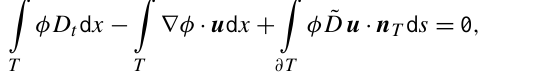
Fig. 10. Linear shallow water equations: kinetic E k , potential E p , and total energy E T versus time t for an implicit midpoint in time and RT 1 × DG 0 in space discretisation of Eqs. (54) and (55). As expected the total energy is conserved to machine precision (the maximum absolute conservation error is 1 . 4 × 10 − 15